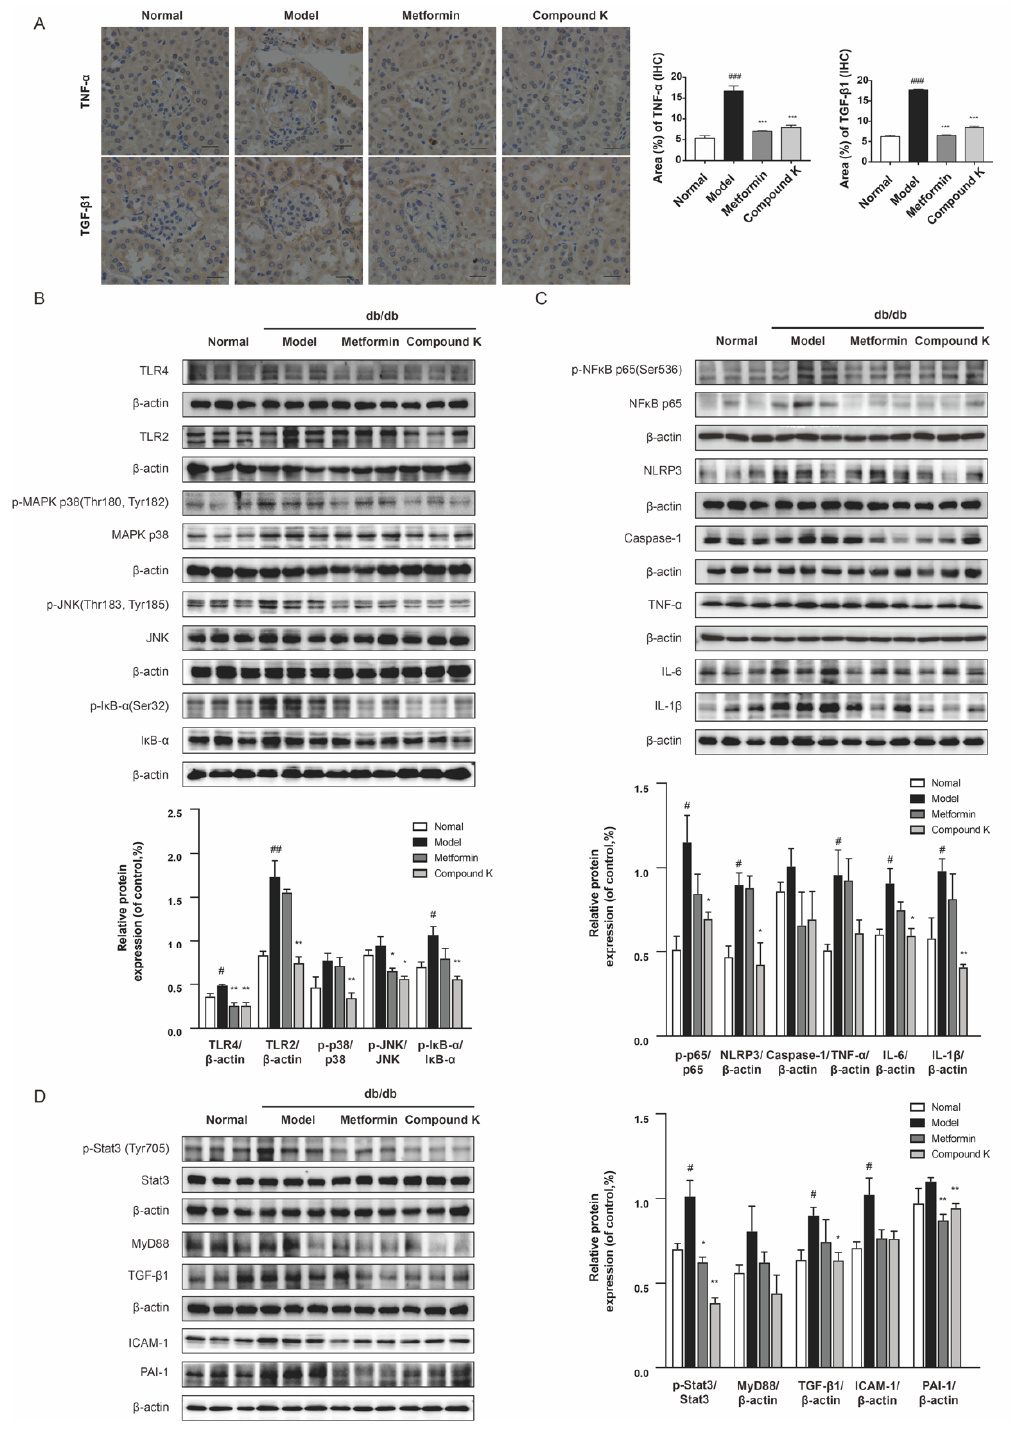
Figure 4. CK supplementation presents inhibiting effects on TLR4 signaling pathway in db/db mice. ( A ) Expression level of TNF- α and TGF- β 1 in renal tissue was detected by immunohistochemistry. Scale bar, 20 µ m. Relative expression examined by immunohistochemistry was analyzed and shown in histogram. ( B ) The levels of TLR4, TLR2 and phosphorylated and total MAPK p38, JNK and I κ B- α proteins. ( C ) The levels of phosphorylated and total NF- κ B p65 and levels of NLRP3, caspase 1, TNF- α , IL-6, and IL-1 β proteins. ( D ) The levels of phosphorylated and total Stat3 and levels of MyD88, TGF- β 1, ICAM-1, and PAI-1 proteins. Data were expressed as means ± SEM ( n = 7). ### p < 0.001, ## p < 0.01, # p < 0.05 compared to normal. *** p < 0.001, ** p < 0.01, * p < 0.05 compared to